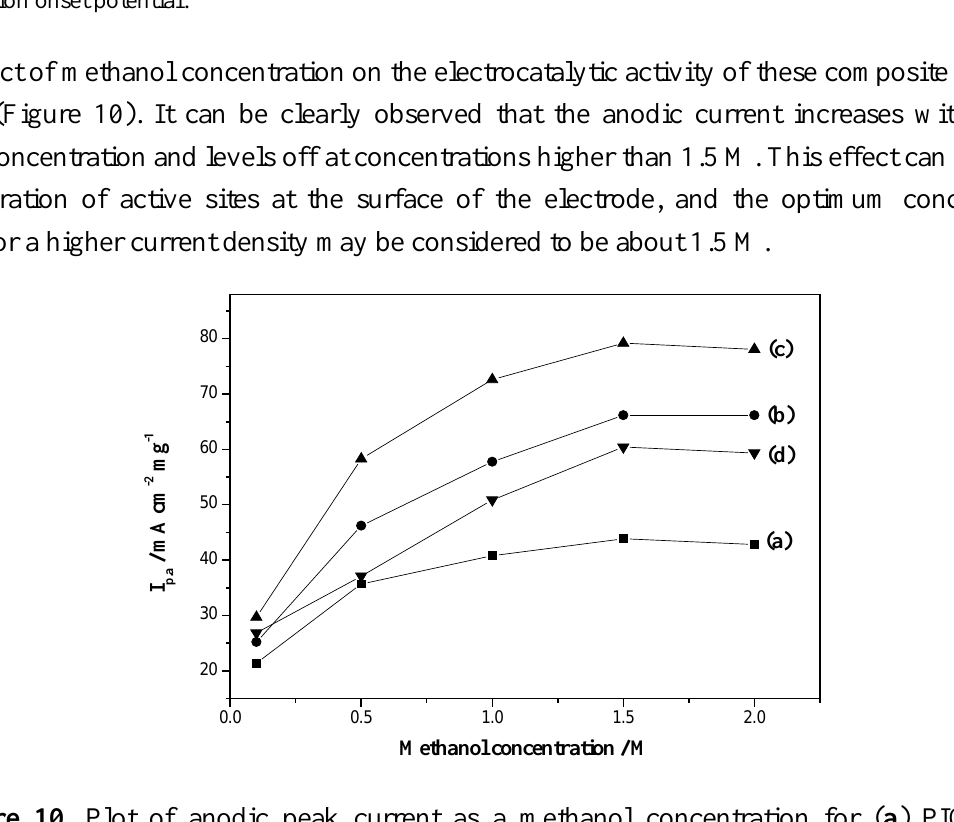
Table 2. Comparisons of the methanol oxidation data in H 2 SO 4 solution at the P(ICA3- co -EDOT2)-Pt composite electrode with some modified electrodes. C H2SO4 /C Methanol ν E onset I pa Electrodes Ref. (M/M) (mV·s −1 ) (V) (c) (mA·mg −1 ) PANI-300PSS-Pt (b) 0.5/0.1 10 0.4 19 [32] Pt/PANI/MGCE (a) 0.5/0.5 5 0.3 32 [33] Pt/Nano-PDAN/MGCE (a) 0.5/2.4 50 0.2 28 [34] PANI-PSS-Pt (b) 0.5/1.0 10 0.4 31 [11] nanotube-Pt (b) 0.5/1.0 50 - 141 [35] P(ICA3- co -EDOT2)-Pt (b) 0.5/0.5 50 0.4 58 This work